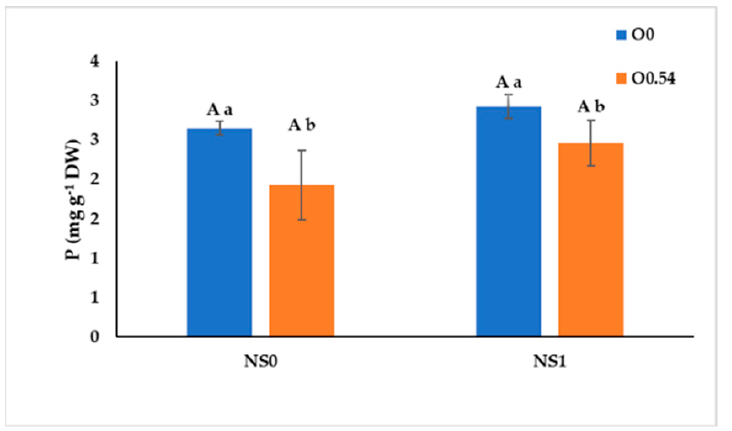
Figure 4. Interactions between fertigation treatments and O 3 supply on P concentration. The comparison between the ozone supplies is assessed with lowercase letters. Capital letters are used to analyze the comparability of fertigation treatments. Different letters denote significant treatment changes (LSD test, p < 0.05).